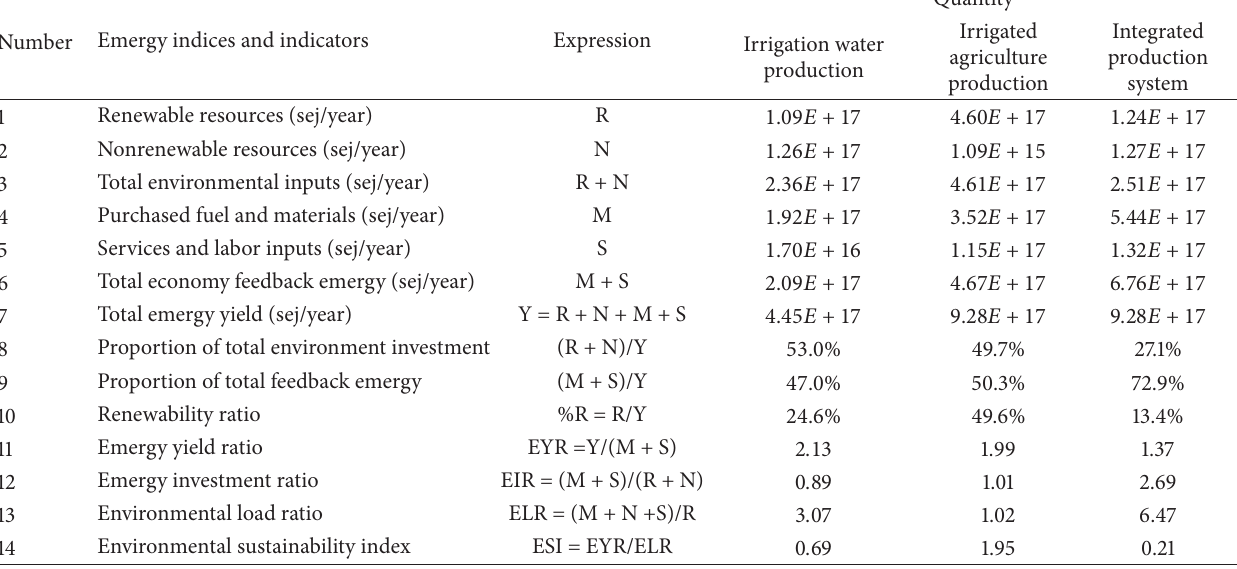
Table 5: Emergy indices and ratios for the integrated production system and for the separated production subsystems.